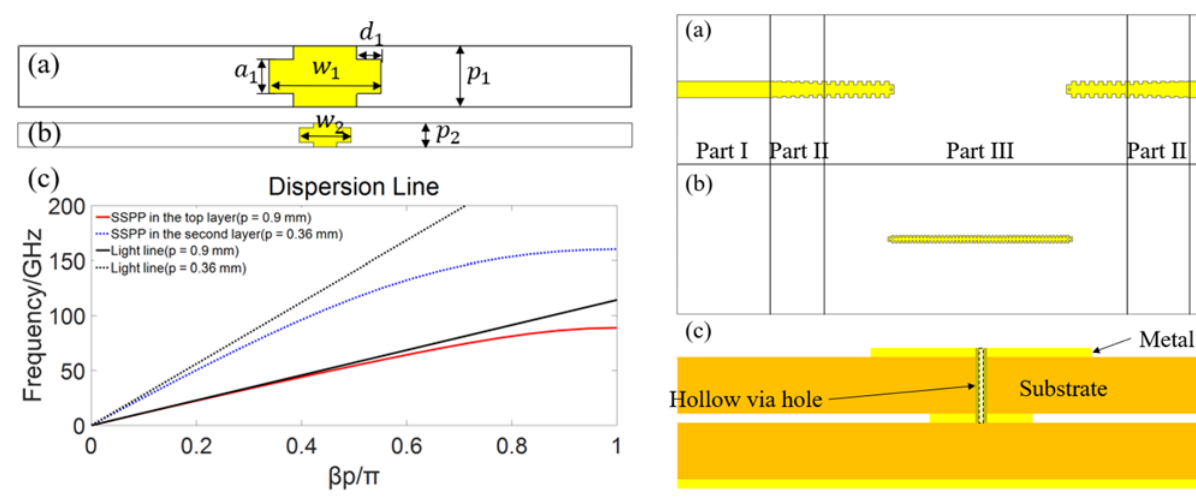
Fig. 1. (a) Sub-wavelength unit in the top copper layer. (b) Sub- wavelength unit in the second copper layer. (c) Dispersion curves of the SSPP TLs in different layers.